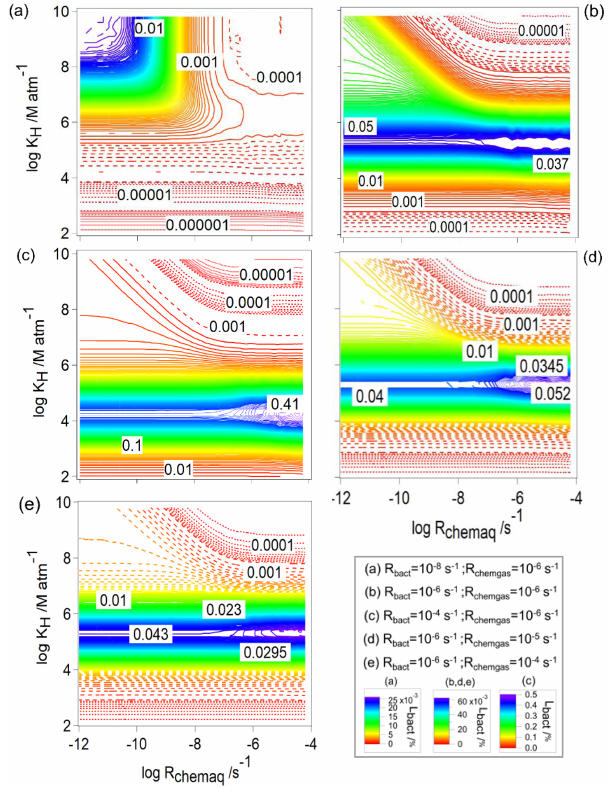
Figure 7. The loss of water-soluble organic gases by bacteria ( L bact , Eq. 11) as a function of R chemaq and K H . All figure panels have the same scales on the ordinates and abscissas. The simulations were performed for constant values of R bact and R chemgas ; their values are indicated in the box at the bottom